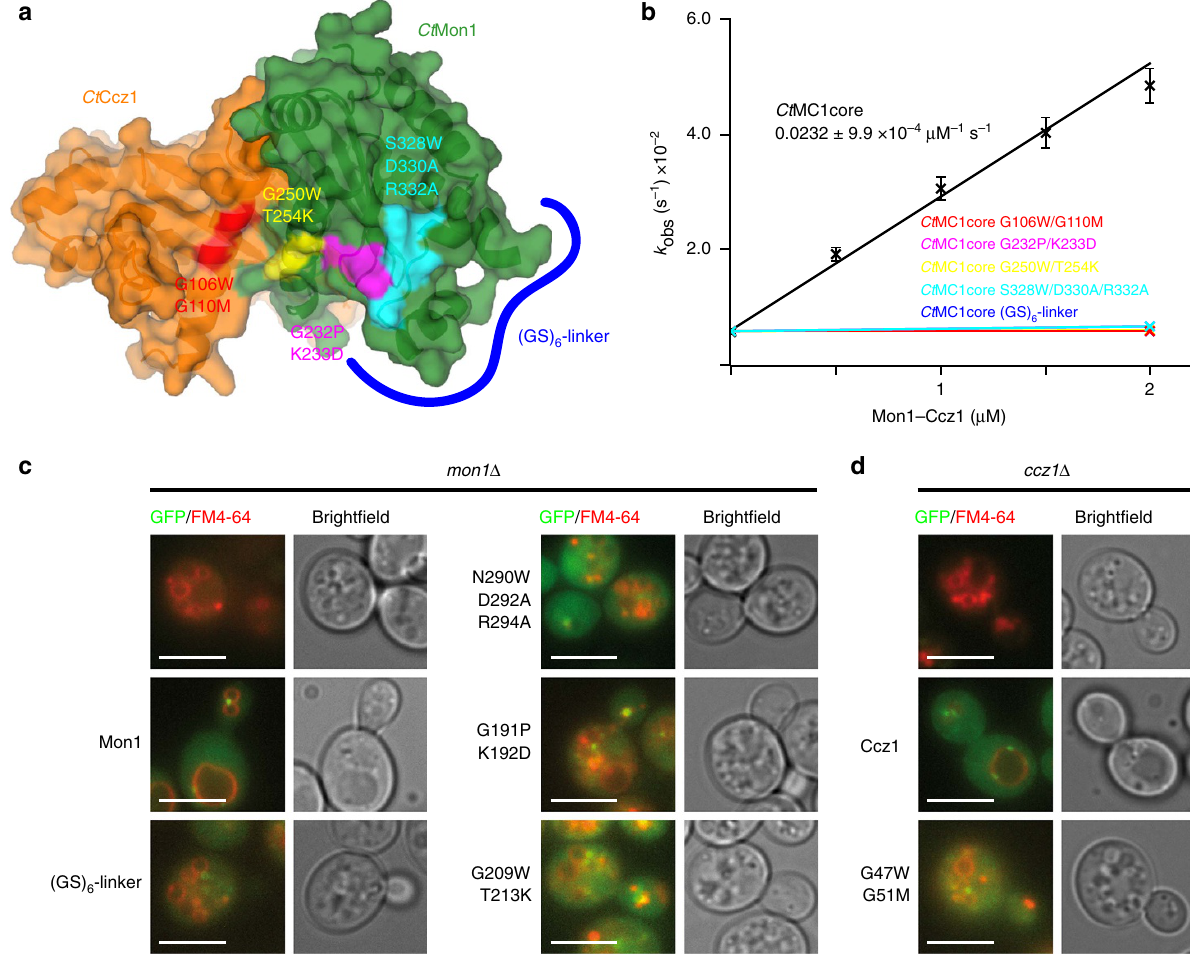
Figure 4 | Interaction of Mon1–Ccz1 with Ypt7. ( a ) Surface representation of the Ct MC1 longin heterodimer. Mutations introduced in the interaction interface with Ypt7 are labelled. ( b ) Nucleotide exchange rates of Ypt7 are plotted as a function of the concentration of Ct MC1core wild-type and different mutations. Error bars represent s.d. of three independent biological repeats. Colours of the graphs correspond to highlighted mutations in a . Functionality test of mutations in ( c ) mon1 D and ( d ) ccz1 D yeast knockout strains. The vacuolar fragmentation phenotype is rescued by the introduction of Sc Mon1 and Sc Ccz1, respectively, but not the mutations corresponding to the GEF-deficient mutants described above. Scale bars: 5 m m.